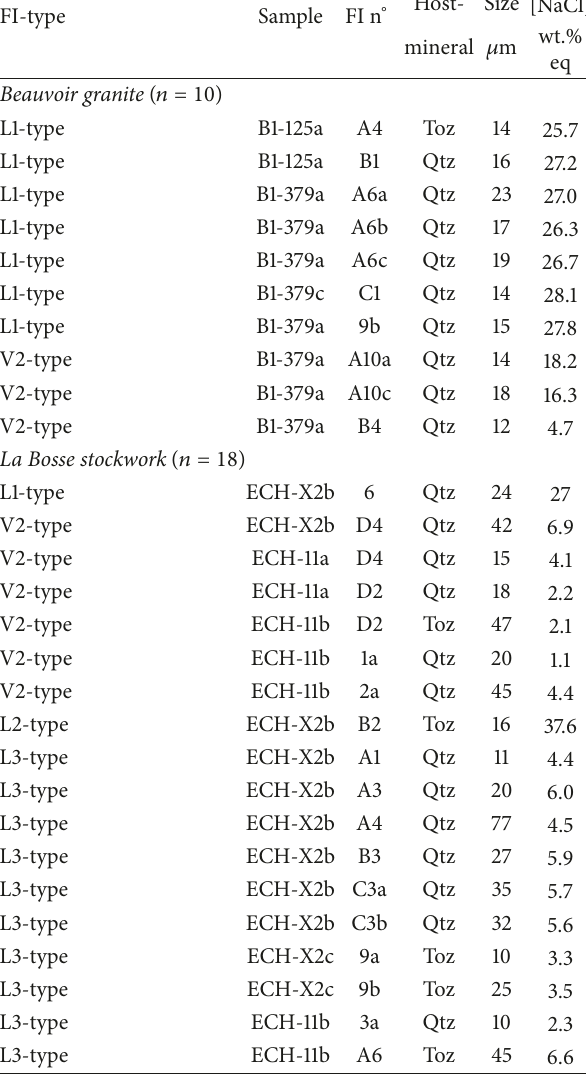
Table 3: Salinity estimated from Raman spectrometry data for fluid inclusions analysed using the method of Caumon et al.